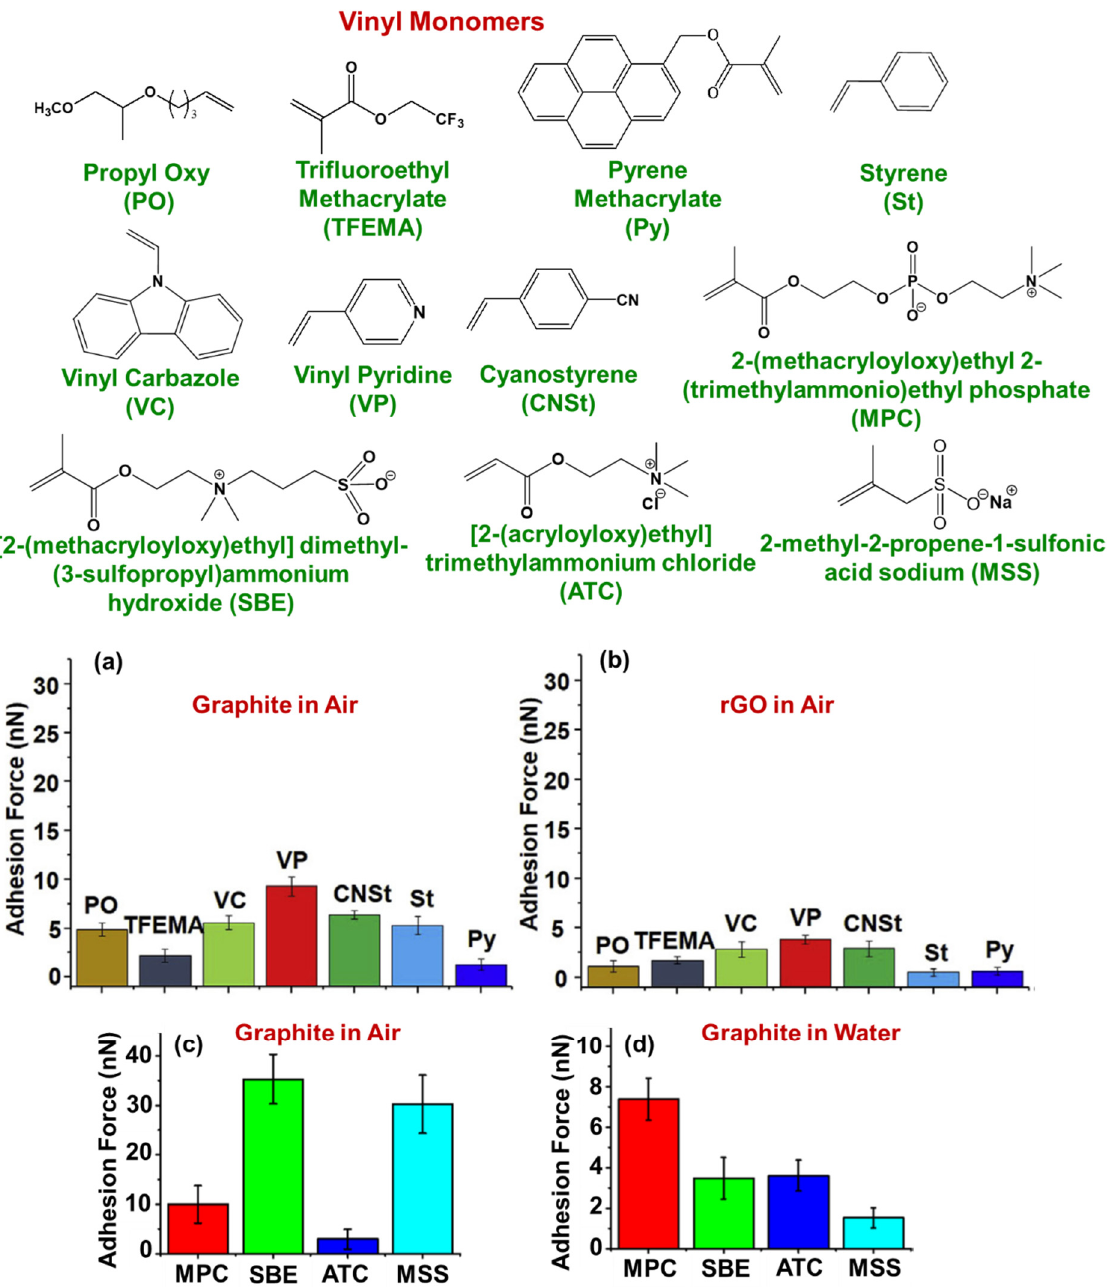
Figure 6. Names and structures of the vinyl monomers used for adhesion force studies of vinyl monomers in air with a graphite surface ( a ) and with an rGO surface ( b ). Adhesion force studies of zwitterion vinyl monomers in air with a graphite surface ( c ) and in water with a graphite surface ( d ). Figures ( a – d ) were reproduced from Refs. [114,115] with permission.